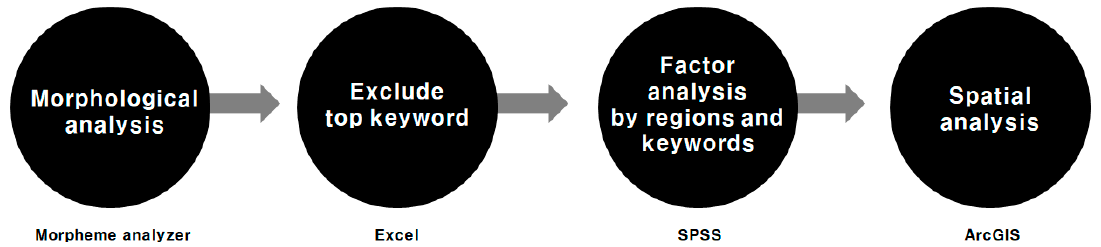
Figure 1. Schematic of the research procedure.